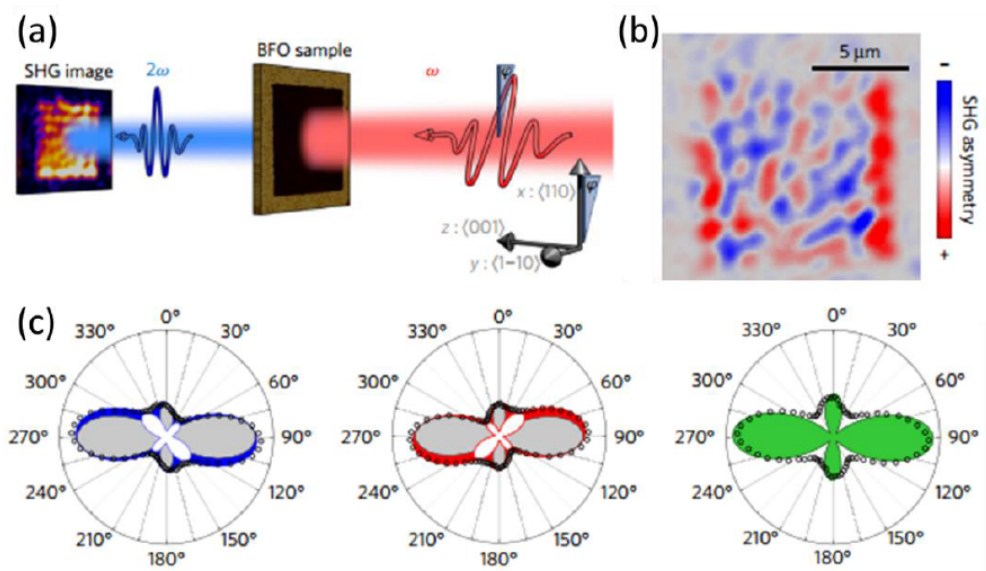
Figure 13. Multiferroic domain mapping in a BFO thin film. ( a ) SHG imaging set up. ( b ) The spatially resolved anisotropy corresponding to antiferromagnetic domains. ( c ) Polarizer measurements in different areas of the sample showing a spatially distributed anisotropy in the polarizer symmetry. Reprinted by permission from [113]. Copyright Macmillan Publishers Ltd.: Nature Materials, 2017.